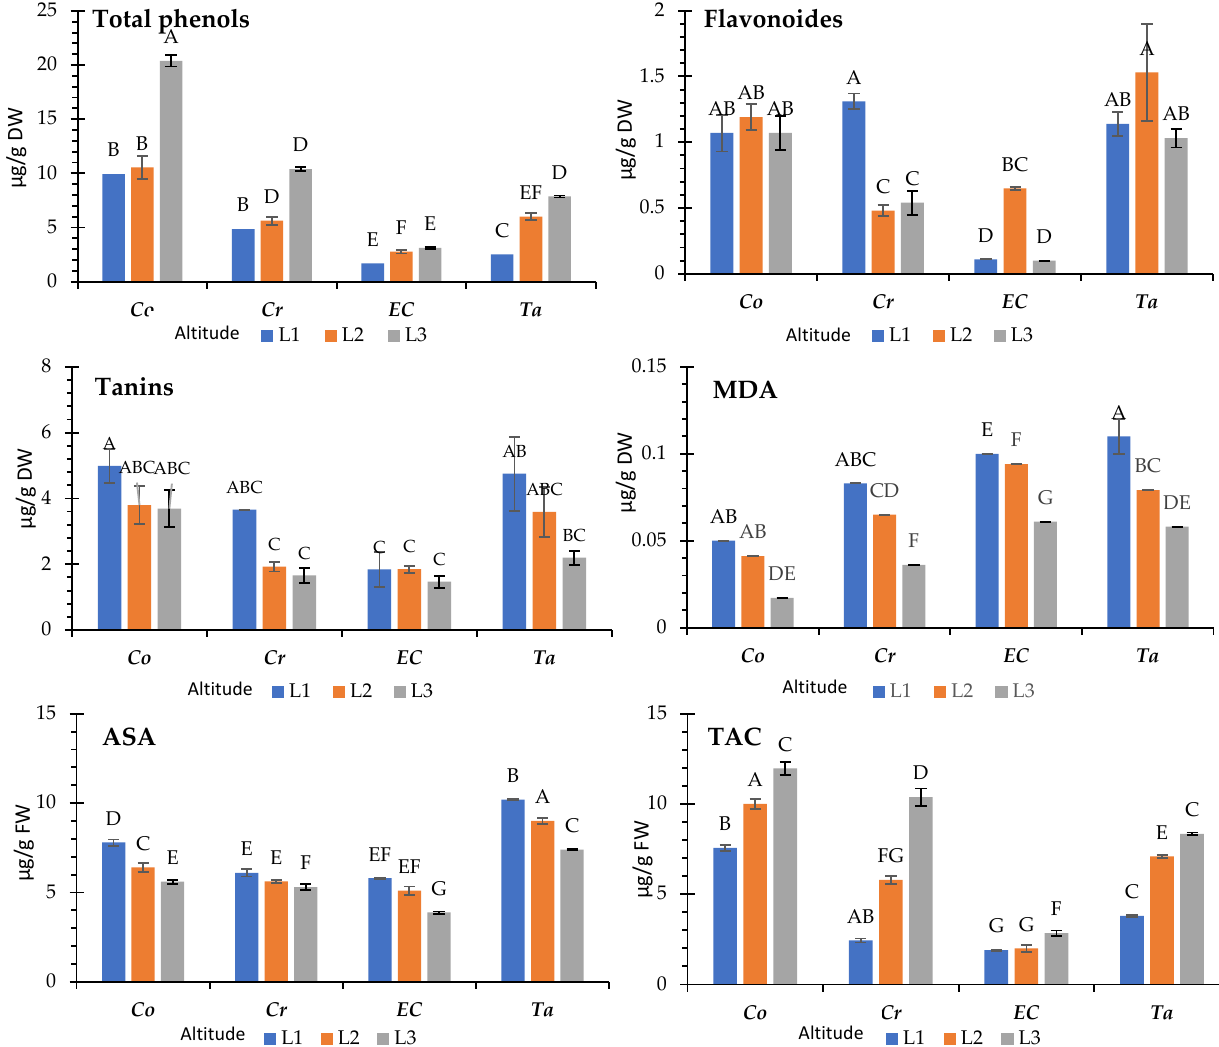
Figure 7. Total phenols, flavonoids, tannins, total antioxidant capacity (TAC), ascorbic acid (ASA), and malondialdehyde (MDA) contents in the leaves of the target species from different altitudes. Each value is the mean of three replicates ± SE. At p ≤ 0.05, bars with different letters are significantly different. Abbreviations: L1 = altitude 1; L2 = altitude 2; L3 = altitude 3; Co . = Cotineaster orbicularis ; Cr. = Crataegus sinaica; Ec. = Echinops spinossissmus; Ta. = Tanacetum sinaicum.